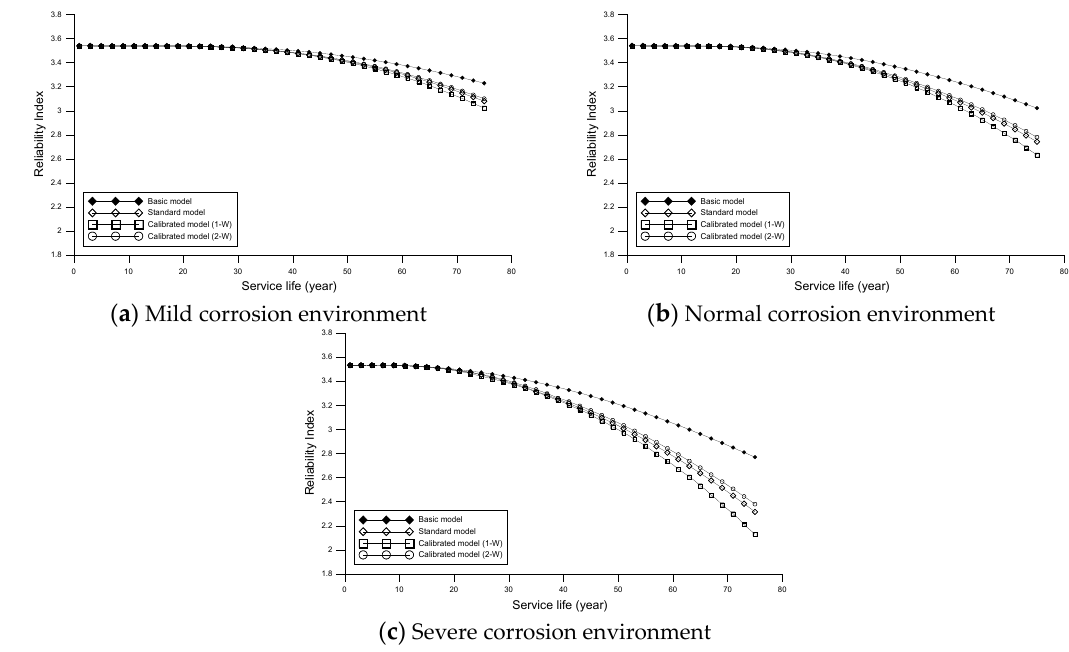
Figure 9. Reliability degradation under normal traffic characteristics (with previous inspection).